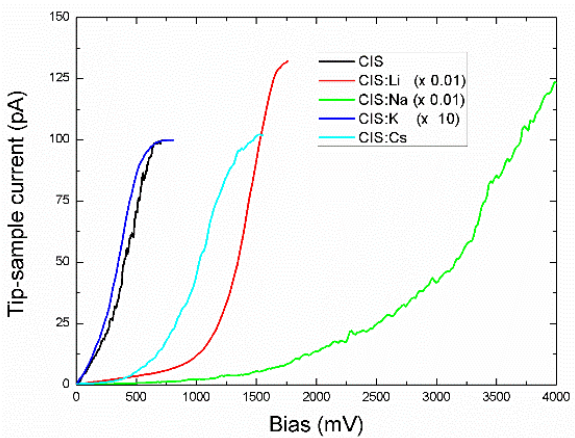
Figure 5. Averaged and corrected CAFM IV curves in the forward sweep and first quadrant of the undoped CIS and alkaline-doped CIS films.